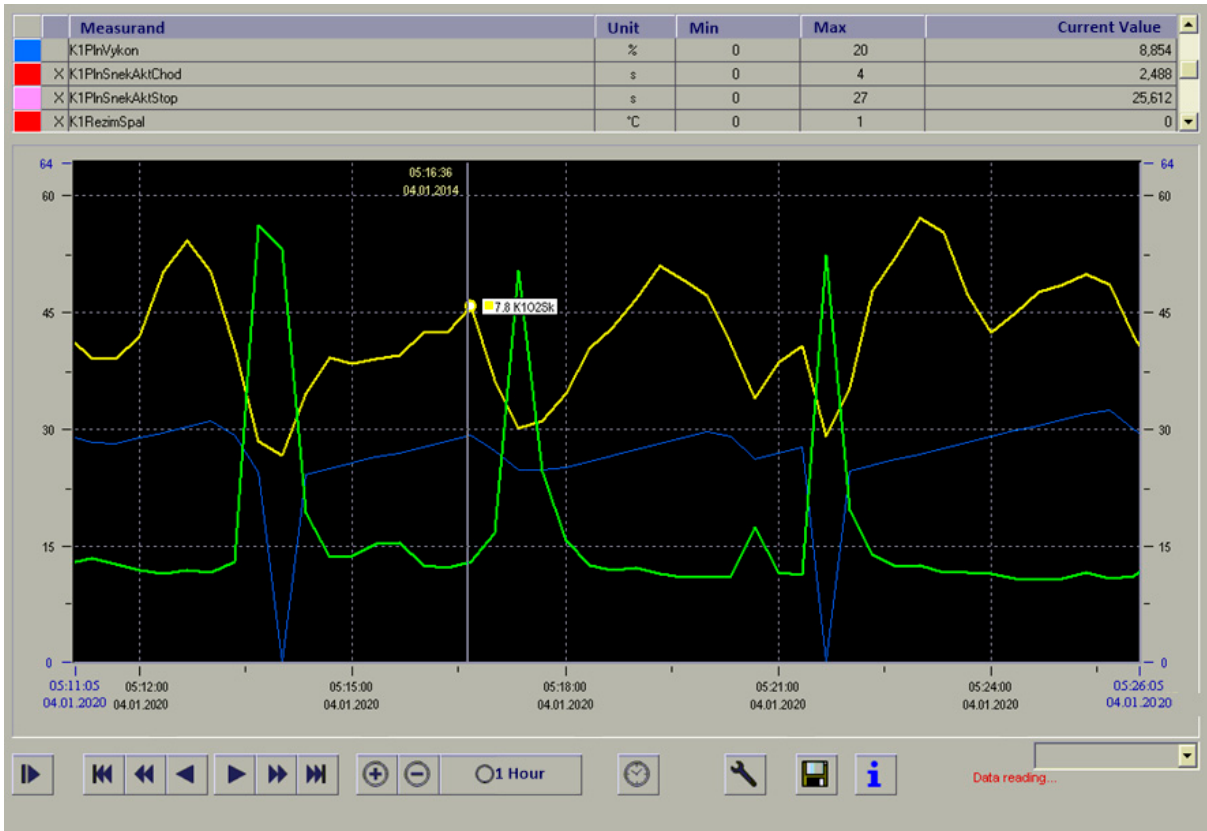
Figure 8. The combustion stabilization by the fuel supply control. Identification of variables: yellow line—the O 2 concentration, green line—the CO emissions, dark blue line—the fuel supply.